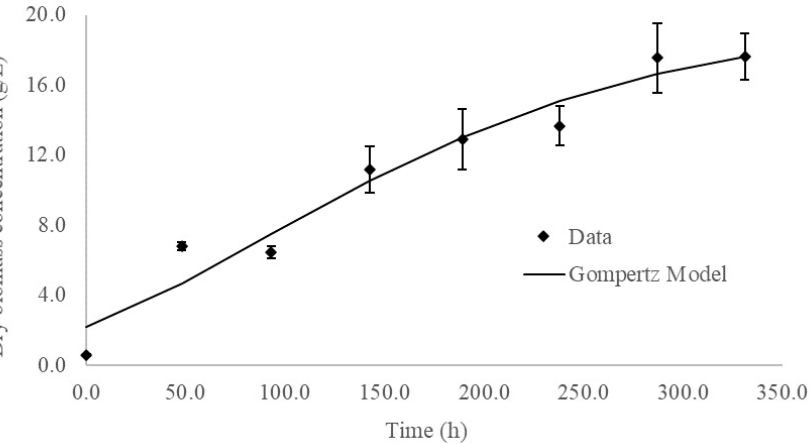
Figure 4. Growth kinetics of the Ganoderma sp. in the flask culture. Error bars indicate the standard deviation of three independent replicates.